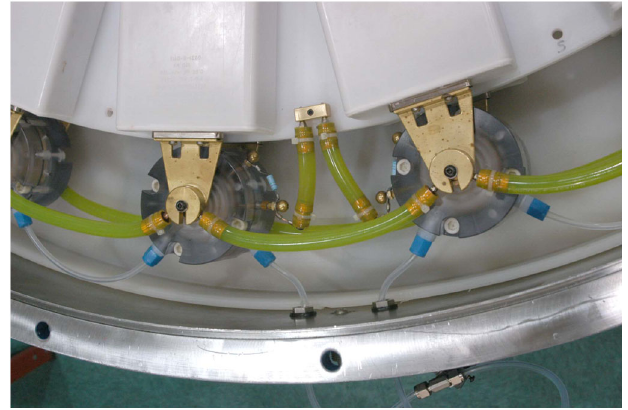
FIG. 7. Details of LTD-III connections with 58-nF capacitors, and all liquid charge and trigger